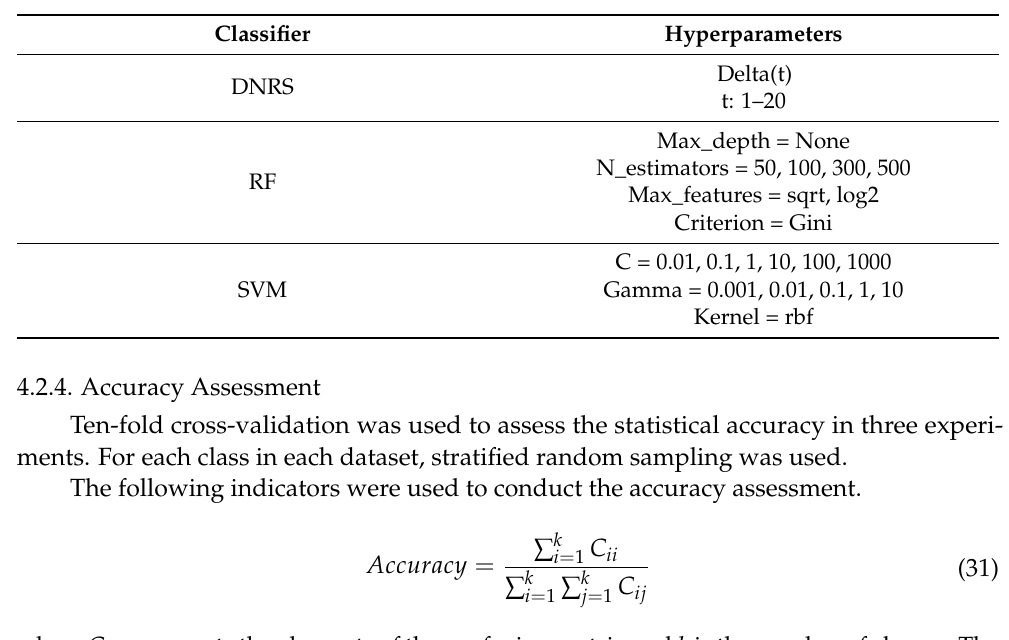
Table 3. Range of